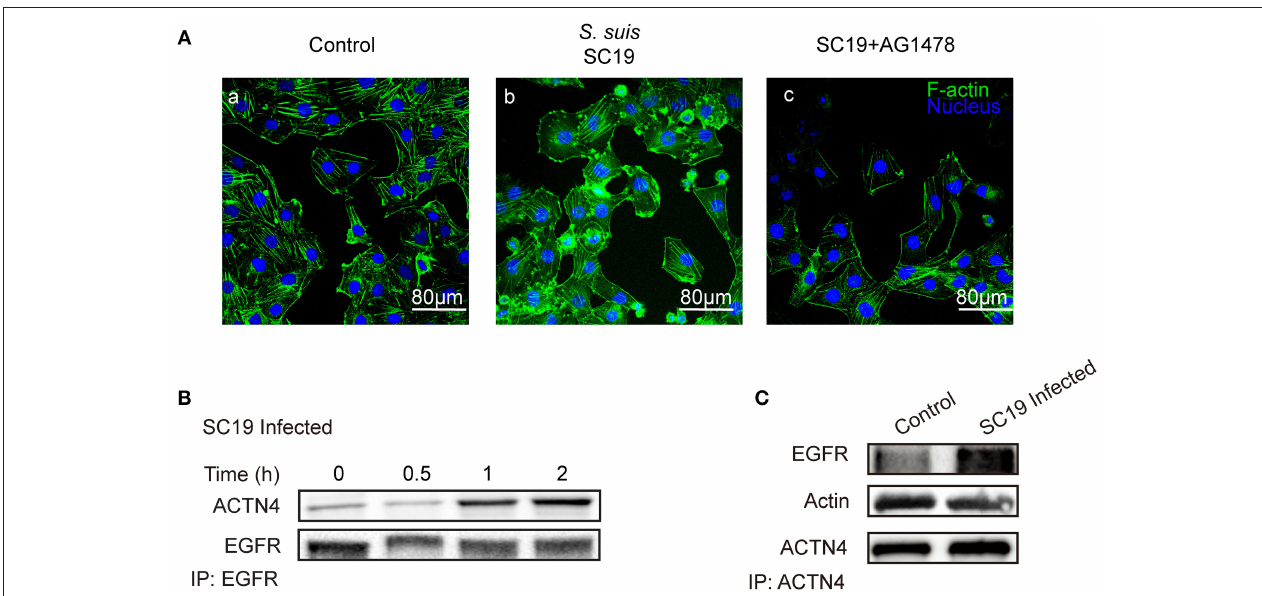
FIGURE 6 | S. suis SC19 infection can activate EGFR and competitively recruit ACTN4. (A) Confocal fluorescence microscopy showing the contribution of EGFR activity to S. suis SC19-induced F-actin breakdown and cytoskeleton rearrangement. F-actin was labeled with actin-tracker green, and nuclei were stained with DAPI. (B) Immunoprecipitation and western blotting revealed the increased recruitment of ACTN4 by EGFR over time during the infection. Anti-EGFR antibody was used for the immunoprecipitation experiments. (C) Immunoprecipitation and western blots showing the increased EGFR association with ACTN4, and the decreased association of F-actin with ACTN4 during the challenge infection with SC19. Immunoprecipitation was carried out using an anti-ACTN4 antibody.